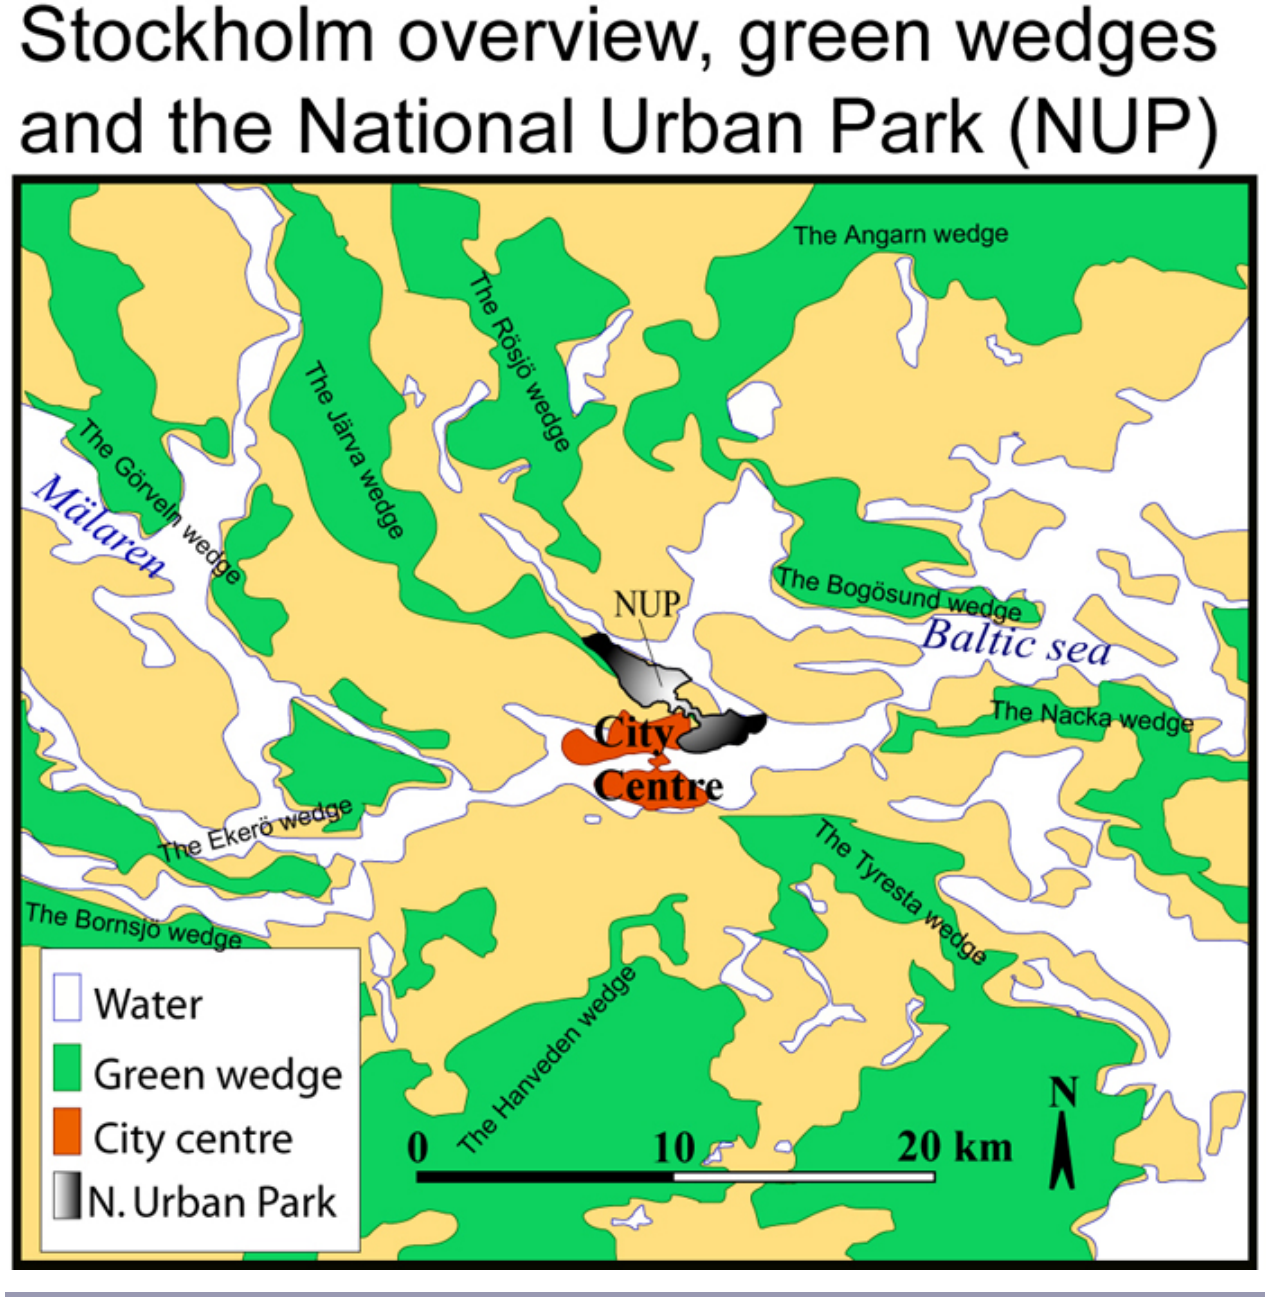
Fig. 1 . Overview of the green space structure in Stockholm and the location of the National Urban